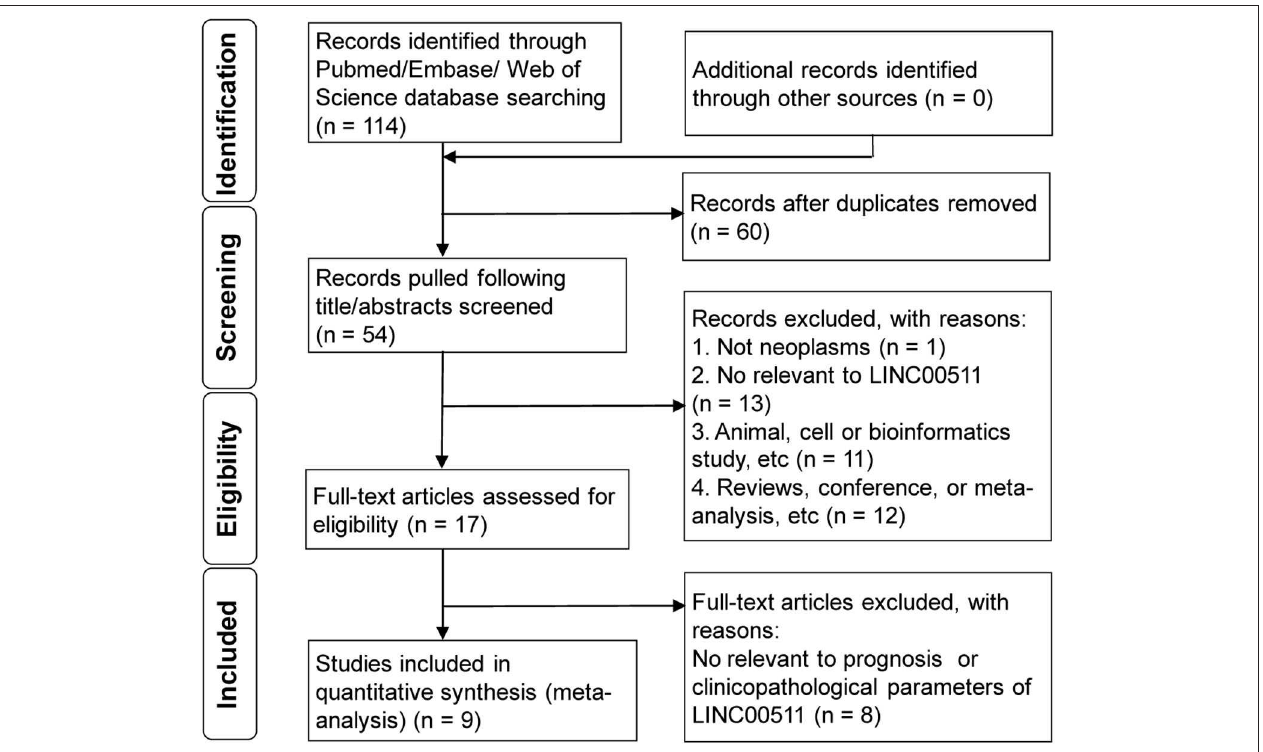
FIGURE 1 | The flow diagram of this meta-analysis.